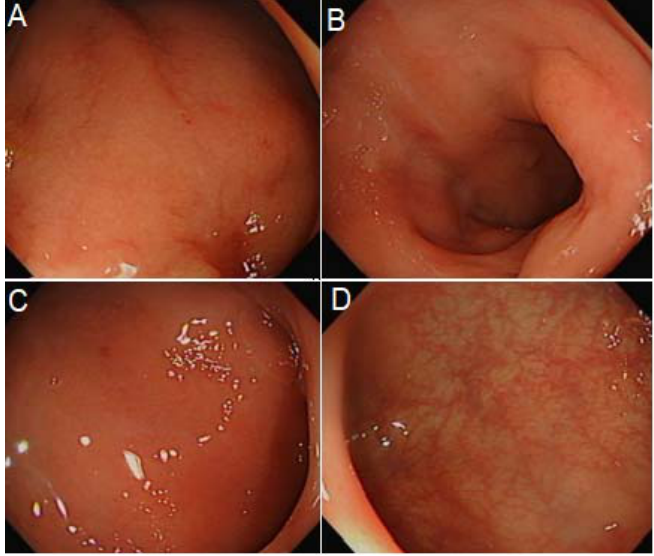
Figure 3. From rectum to splenic flexure ( A – D ): findings of proctocolitis, however, improved compared with previous sigmoidoscopy.